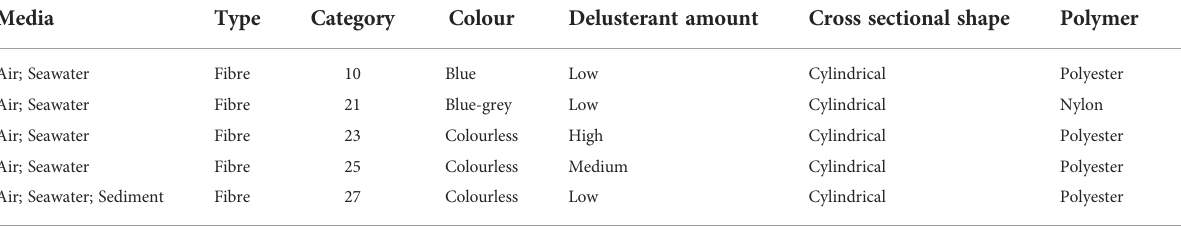
TABLE 1 The characteristics and number of microplastic fi bre categories present in two or more sample media.